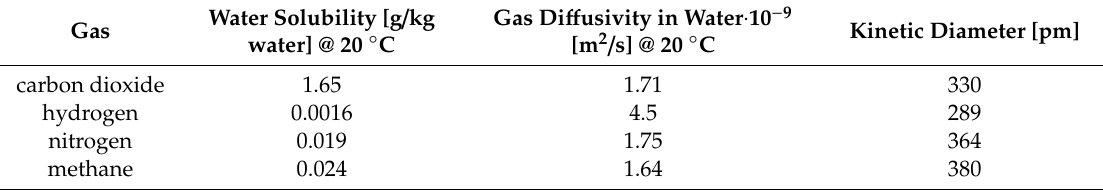
Table 1. Water Solubility, Gas di ff usivity in water and kinetic diameter for CO 2 , H 2 , N 2 and CH